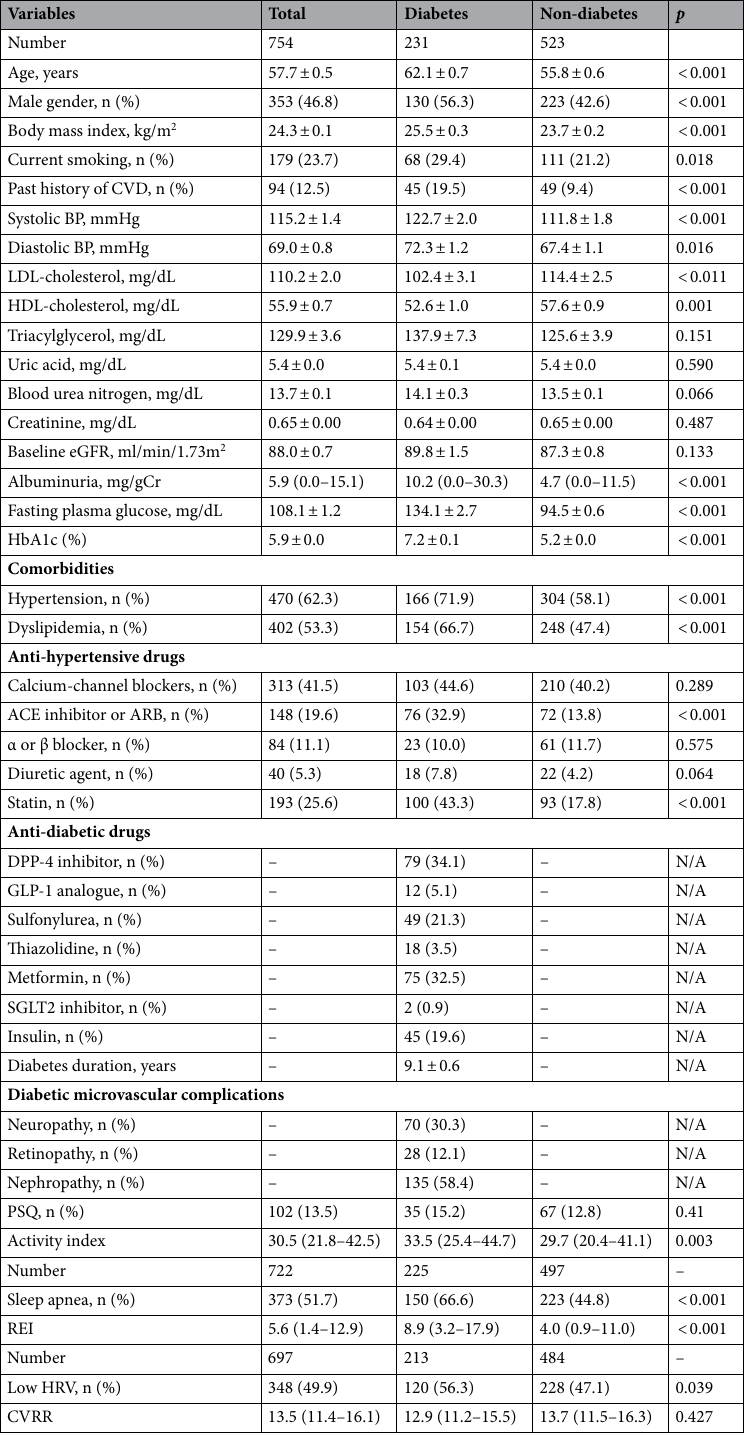
Table 1. Comparisons of baseline clinical characteristics between patients with and without diabetes. Data are presented as the mean ± standard error or median (25th–75th percentile) for continuous variables or number (%) for dichotomous variables. P values are shown for comparisons of mean (t-test) and median (Mann– Whitney test) values. Percentages were determined with a chi-squared test. CVD cardiovascular disease, BP blood pressure, LDL low density lipoprotein, HDL high density lipoprotein, eGFR estimated glomerular filtration rate, ACE angiotensin converting enzyme, ARB angiotensin II receptor blocker, DPP dipeptidyl peptidase, GLP glucagon-like peptide, PSQ poor sleep quality, REI respiratory event index, HRV heart rate variability, CVRR coefficient of variation of R–R interval, NA not